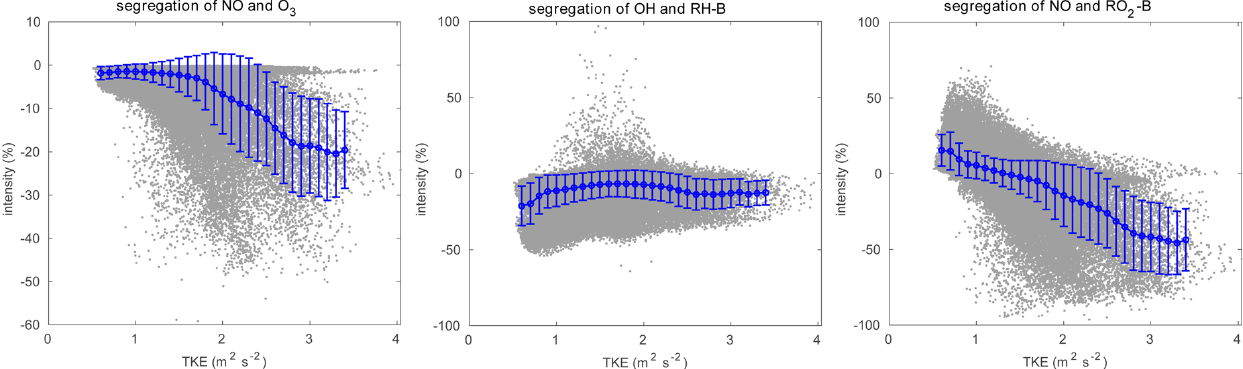
Figure 12. Relationship between segregation intensity and TKE. The grey dots represent the raw data, and the blue dots are the mean value in every TKE bin with a width of 0.1m 2 s − 2 . The error bars show the standard deviations.